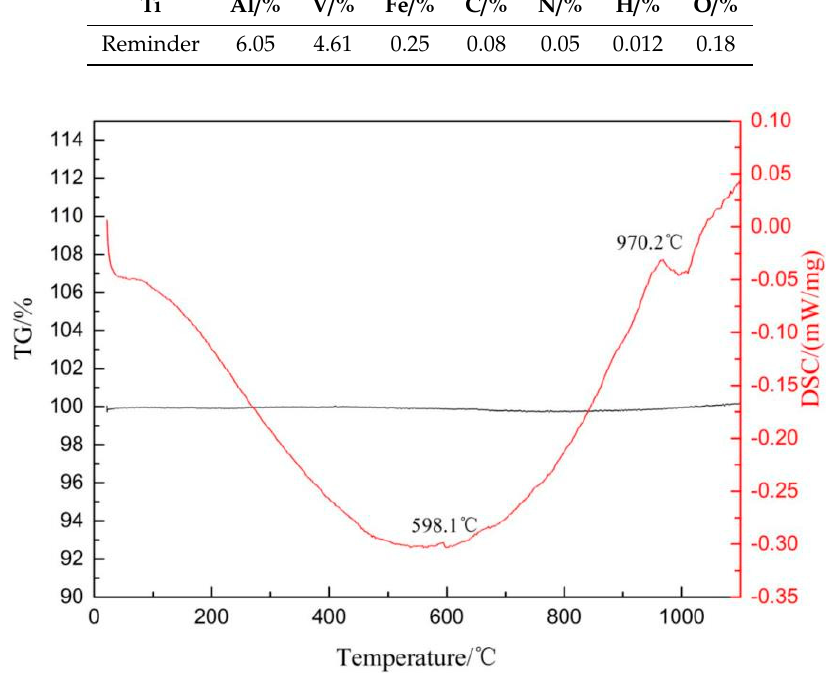
Figure 1. DSC-TG graph of as-received Ti6Al4V alloy. Table 1. Chemical composition of as-received Ti6Al4V alloy.